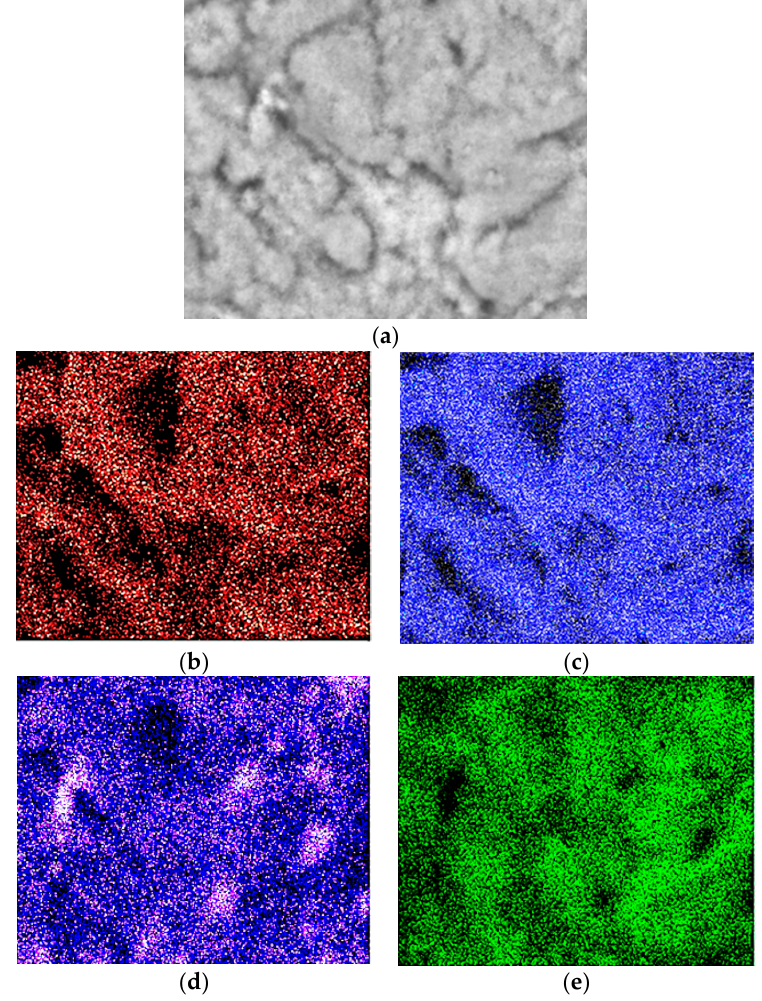
Figure 11. ( a ) SEM micrograph of aluminum specimen dried for 60 min at 100 °C, at 5 K×; ( b ) EDS mapping of C; ( c ) EDS mapping of O; ( d ) EDS mapping of Si; ( e ) EDS mapping of Al.